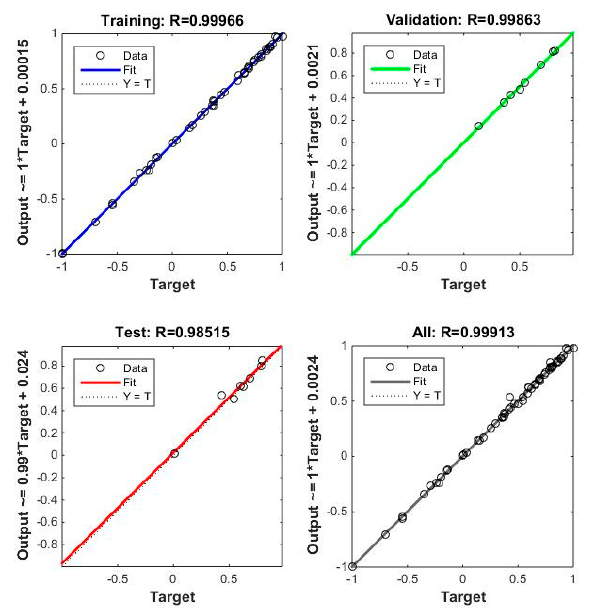
Figure 6. The regression performance analysis of the DNN model.